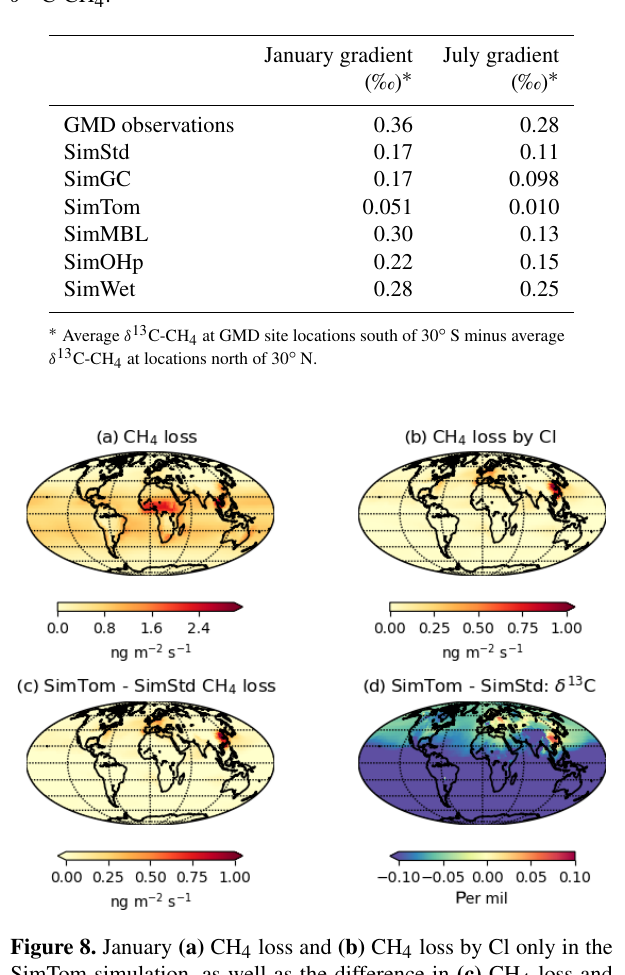
Table 3. Observed and simulated interhemispheric gradient in δ 13 C-CH 4 .